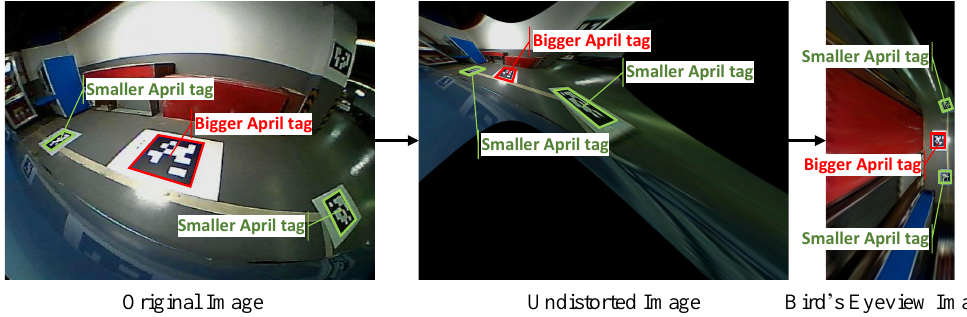
Figure 3. From left to right is the procedure of image undistortion and perspective transformation. The bigger Apriltags indicated with the red box are used to calculate the homography matrix. The smaller Apriltags indicated with the green box are used to montage images.